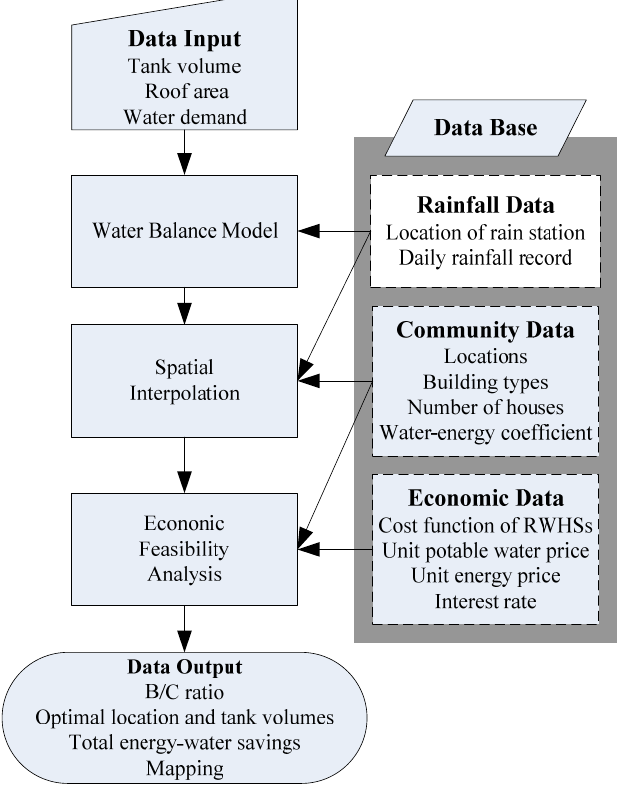
Figure 1. Conceptual framework of